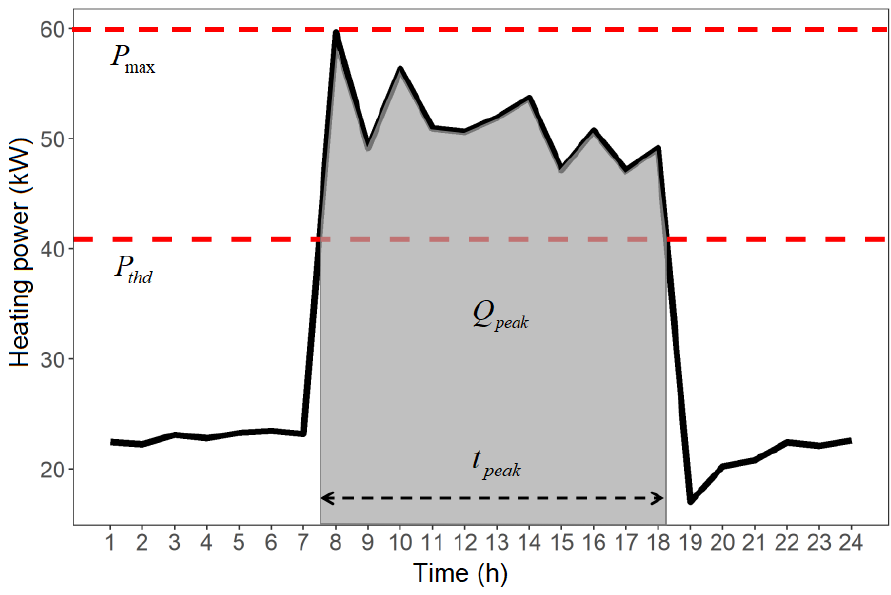
Figure 2. Illustration of parameters on an hourly heating load profile of a day.